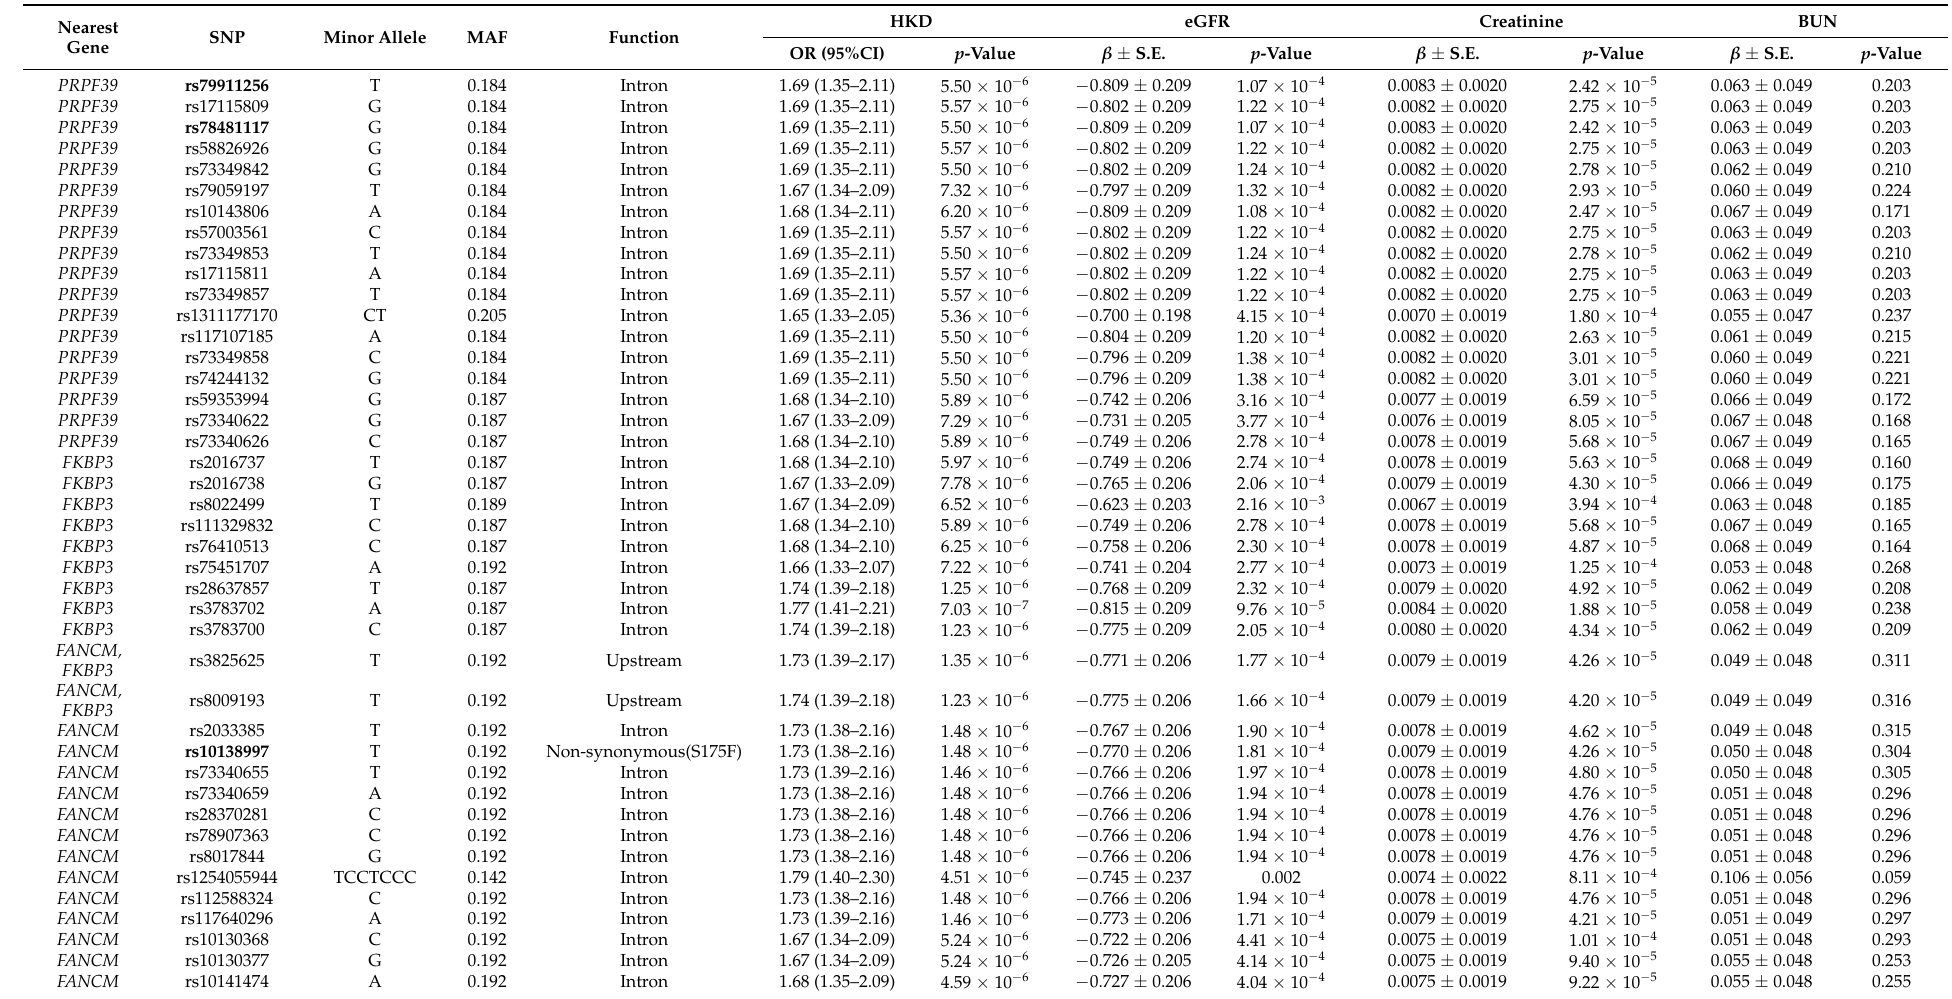
Table 3. Results of an association analysis between SNPs in the PRPF39 , FKBP3 and FANCM genes and hypertensive kidney disease and kidney function-related